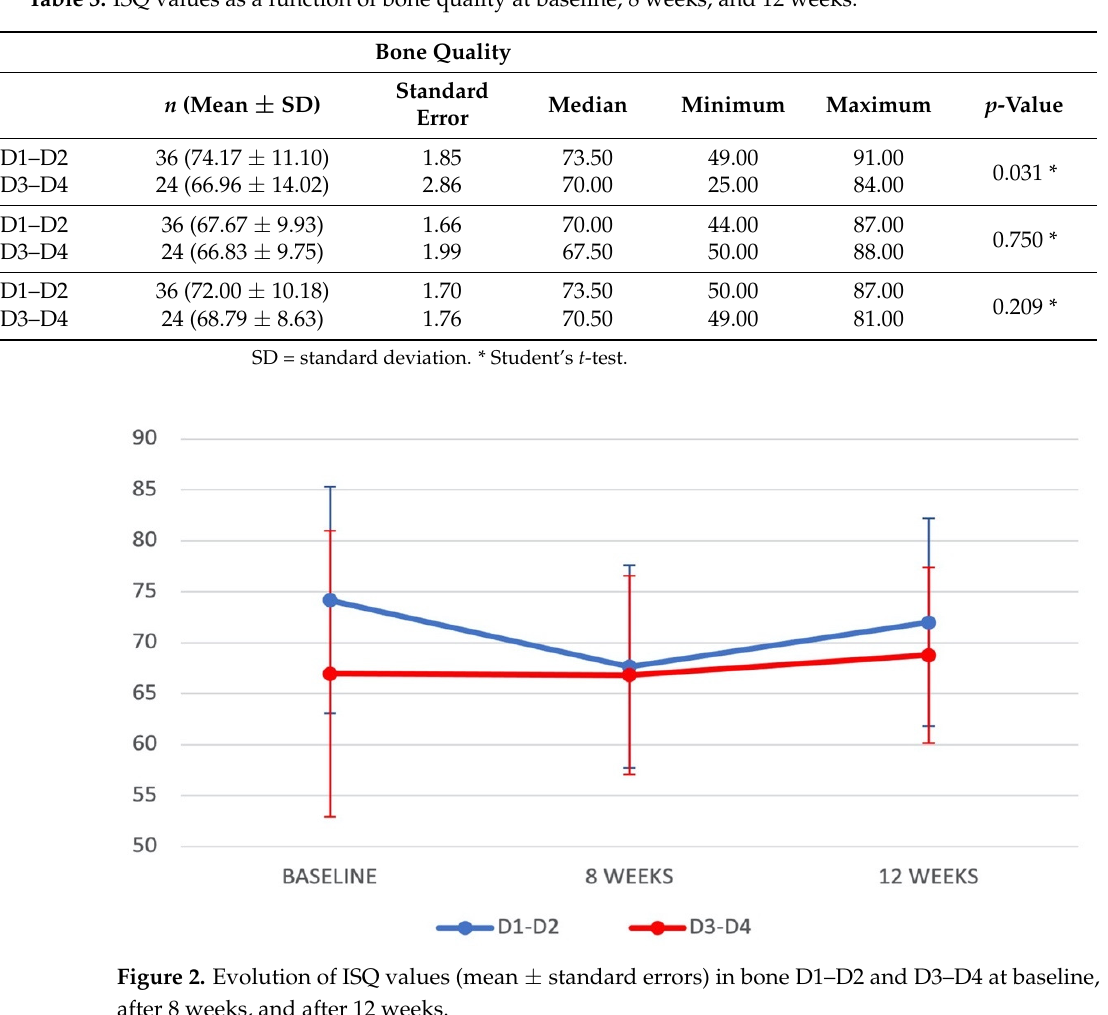
Figure 1. Evolution of ISQ values (mean ± standard errors) in Groups 1 and 2 at baseline, after 8 weeks, and after 12 weeks. Table 3. ISQ values as a function of bone quality at baseline, 8 weeks, and 12 weeks.